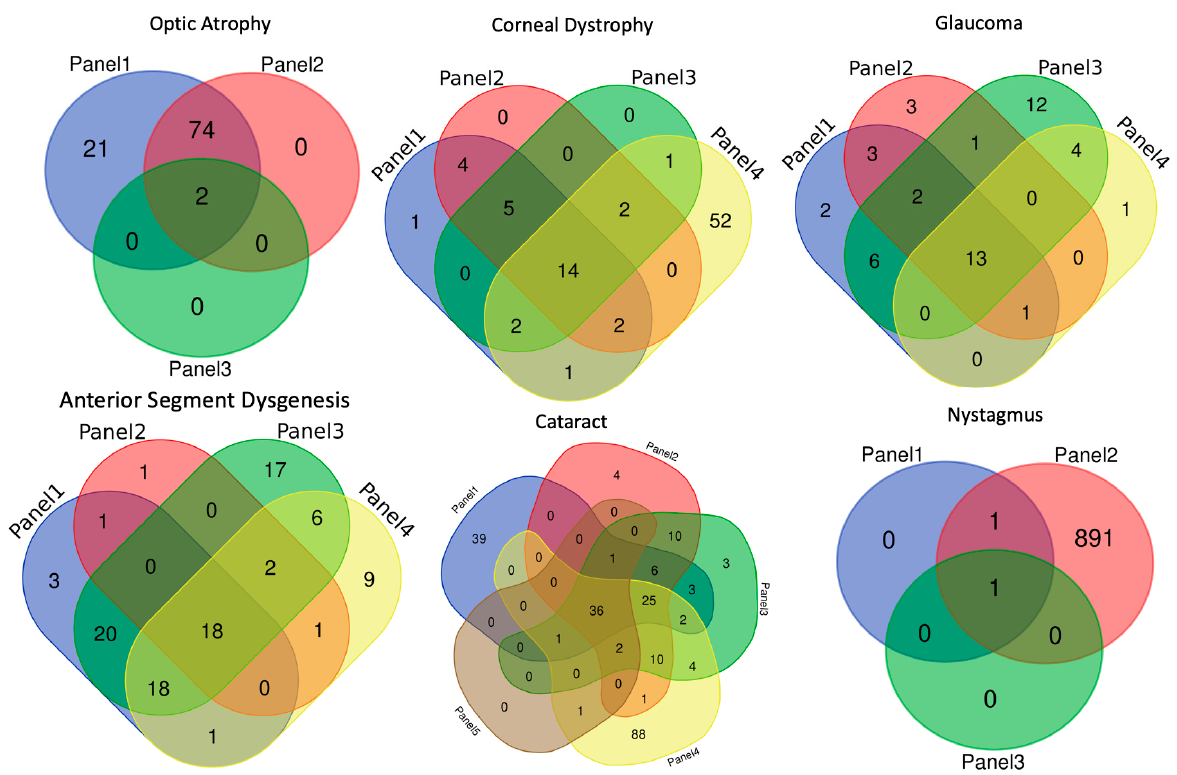
Figure 1. Demonstrates how genes overlap between commercially available panels. Table 1. Common Phenotype/Genotype associations and panel coverage.